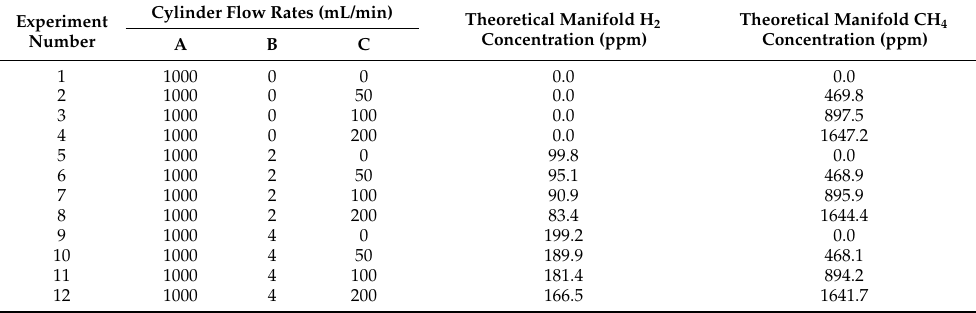
Table 2. The conditions used to generate the variable gas mixtures for sensor calibration and